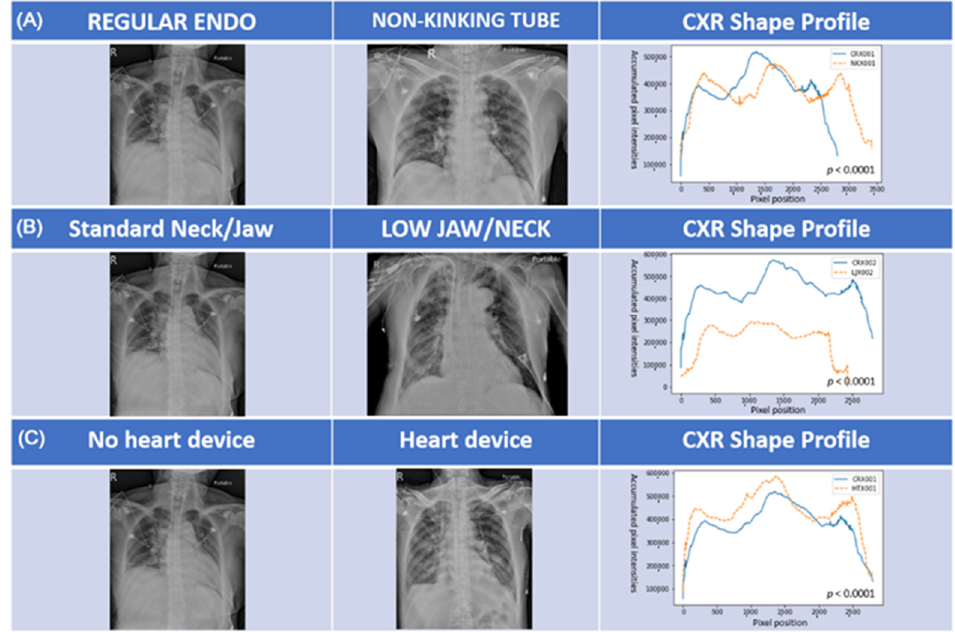
Figure 5. Analysis of the impact of the three major types of image noise using CXR shape profiles; ( A ) effect of tube material (tube factor); ( B ) effect of neck and jaw location (patient factor); ( C ) effect of heart device (environment factor).